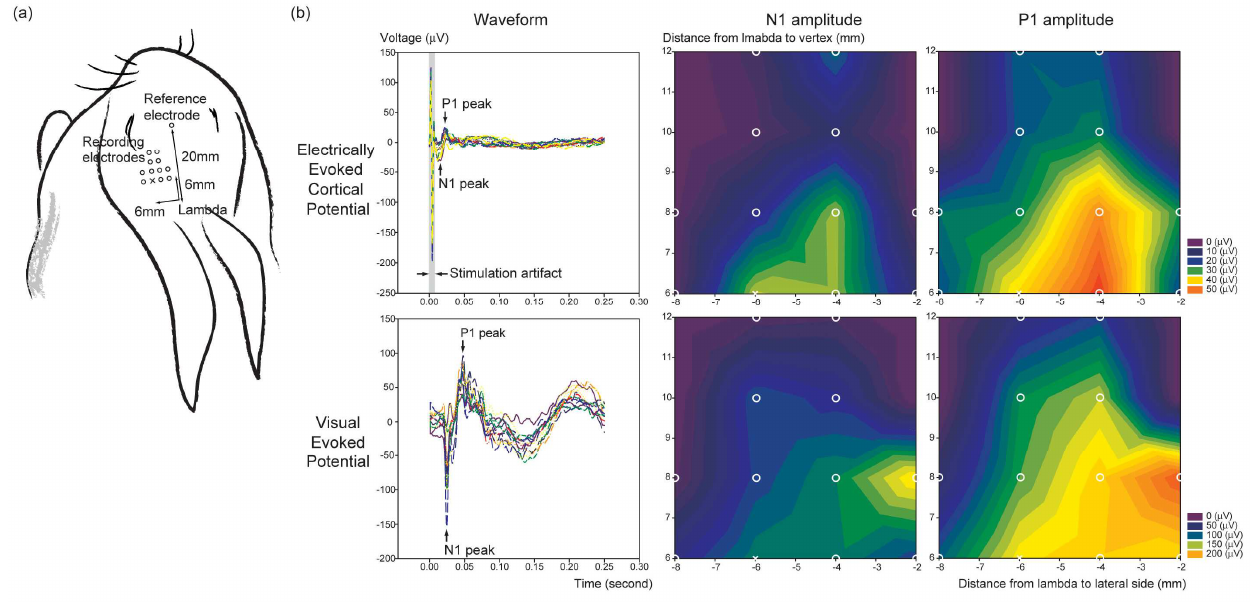
Figure 5. (a) Location of the recording and reference electrodes for the EECP and the VEP measurement in the rabbit. (b) Waveforms of the EECP and the VEP measured by the multi-regional evoked potential recording in twelve spots of the visual cortex, and the isoelectric contour maps of the waveform amplitudes. The EECP and the VEP showed good topographical